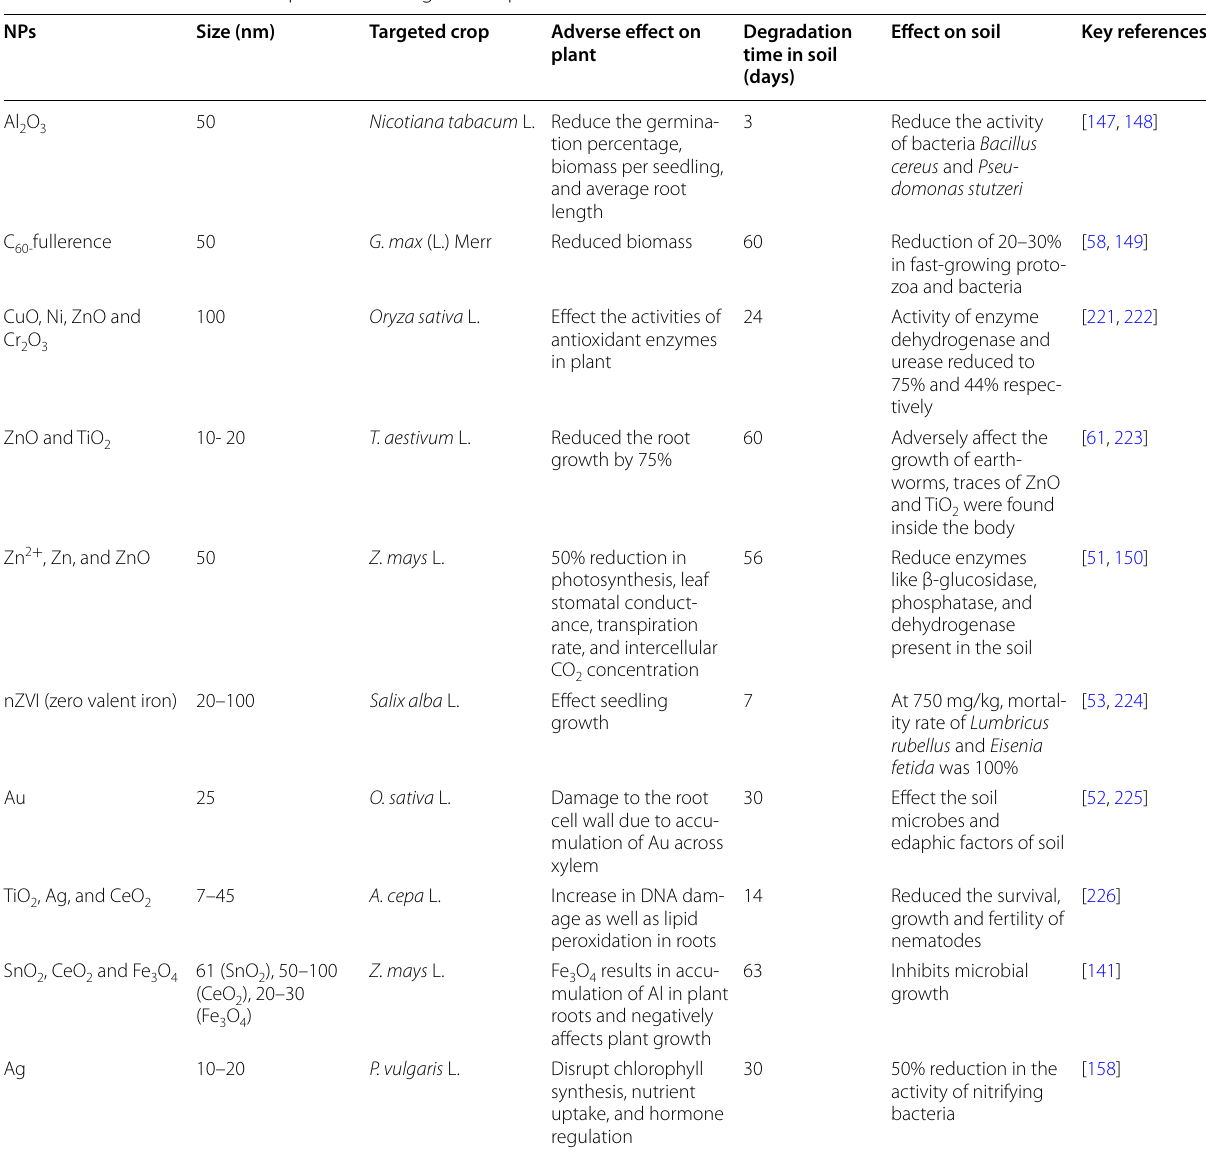
Table 4 Adverse effect of nanoparticles on targeted crop and soil